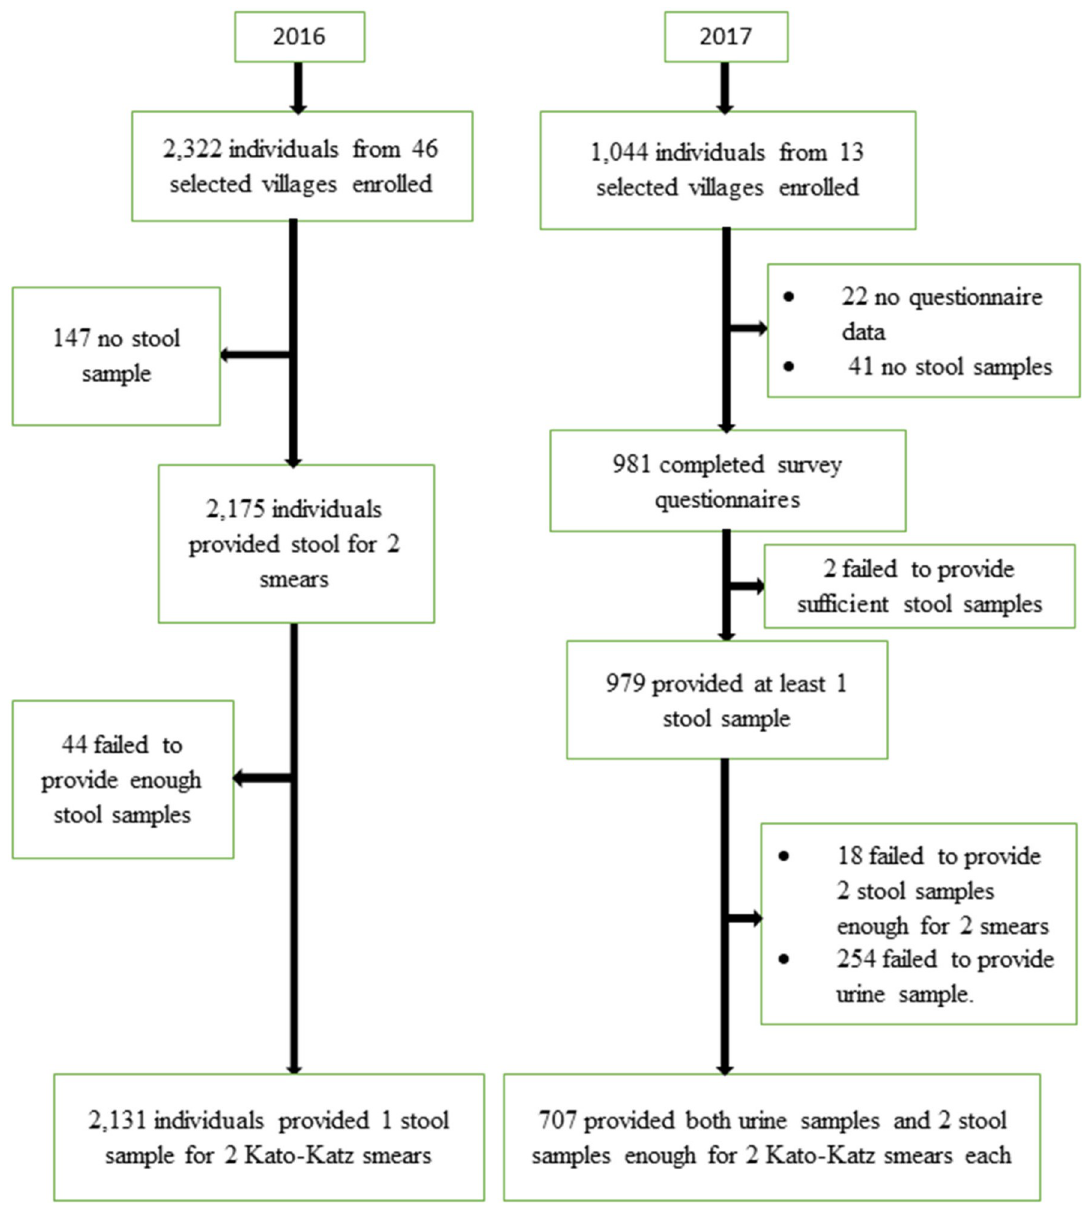
Fig 3. Study participants’ inclusion flowchart for the Ituri schistosomiasis surveys. Left: In 2016, geographical distribution study in 46 villages; Right: In 2017, in–depth study in 12